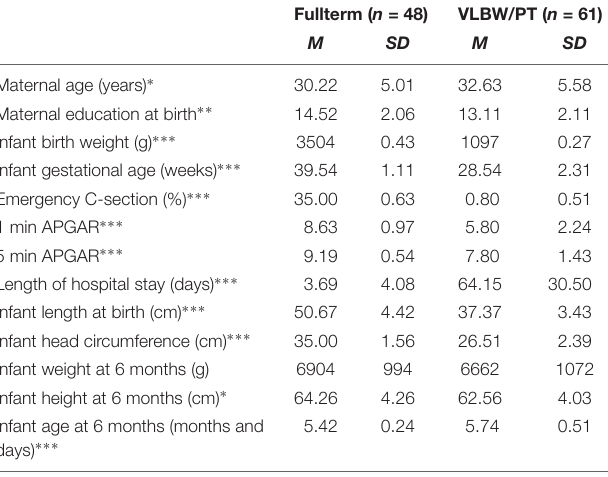
TABLE 1 | Demographic and medical characteristics for fullterm and VLBW/PT